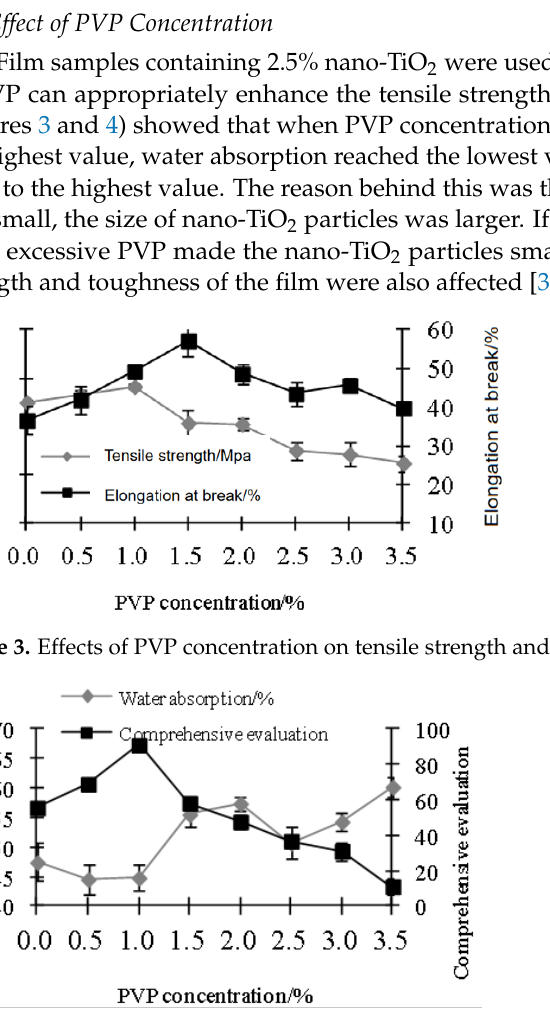
Figure 4. Effects of PVP concentration on water absorption and comprehensive evaluation.